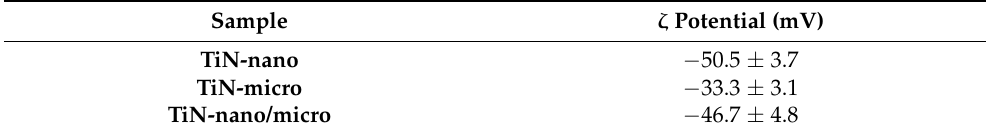
Table 2. ζ potential of TiN-nano, TiN-micro, and TiN-nano/micro suspensions obtained in aque- ous media.